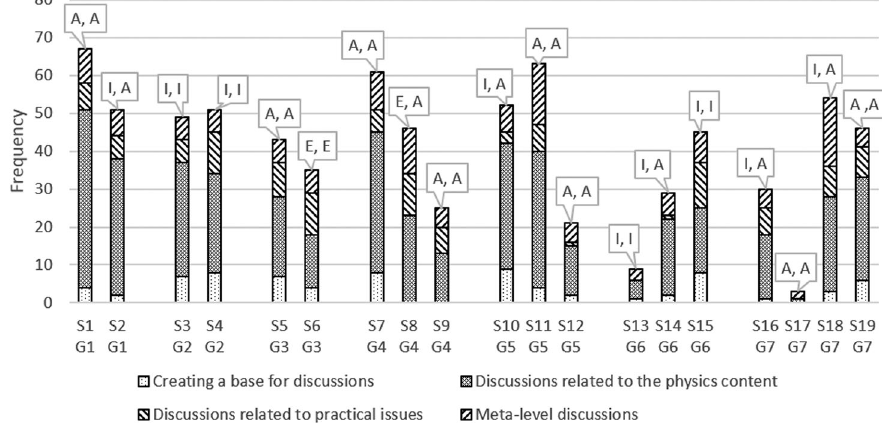
FIG. 3. A categorization of the lines produced by the students. S1 – S19 refer to the individual students and G1 – G7 refer to the discussion groups. The letters within the bubbles above the bars indicate the students ’ responses as seen in the pre- and post-test items (Fig. 1), respectively. A ¼ Acceptable answers, I ¼ Inadequate answers, E ¼ Empty, and uncategorized answers. A line could be placed in more than one category concurrently and hence the frequencies exceed the totals shown in Table III.